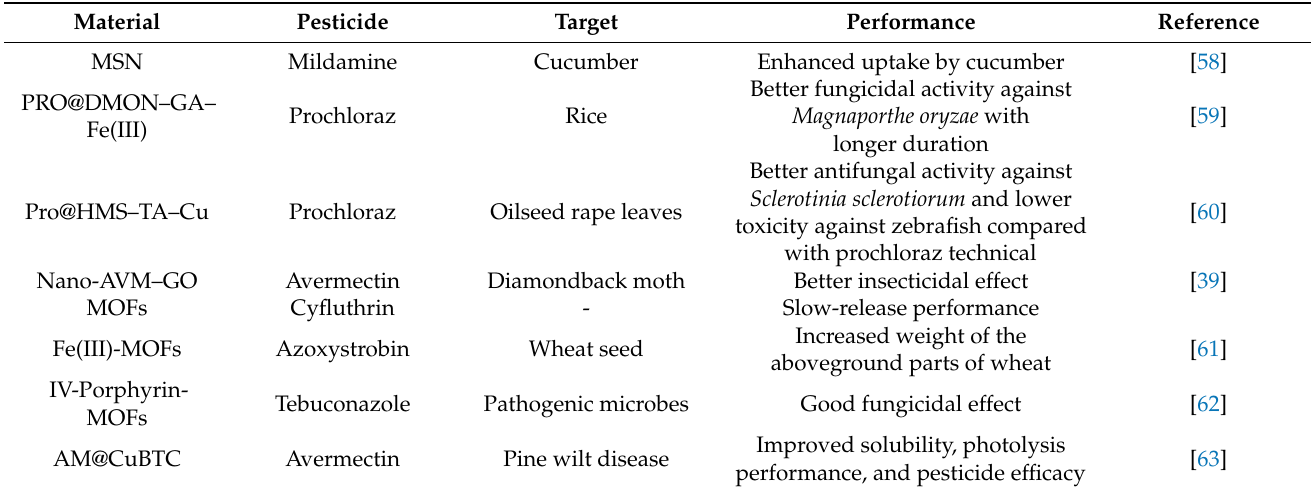
Table 1. Nanopesticides prepared as inorganic